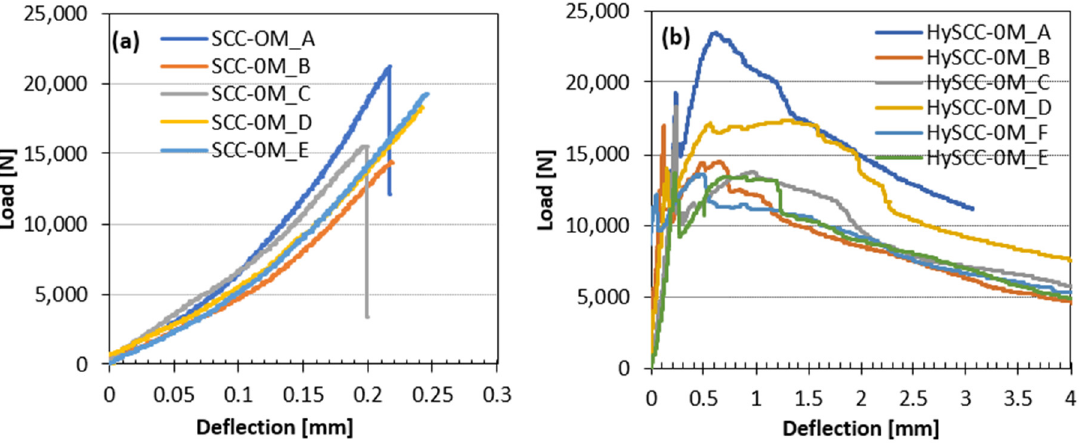
Figure 3. Load–deflection curves of ( a ) SCC-0M without hybrid fibers and ( b ) HySCC-0M with hybrid fibers.